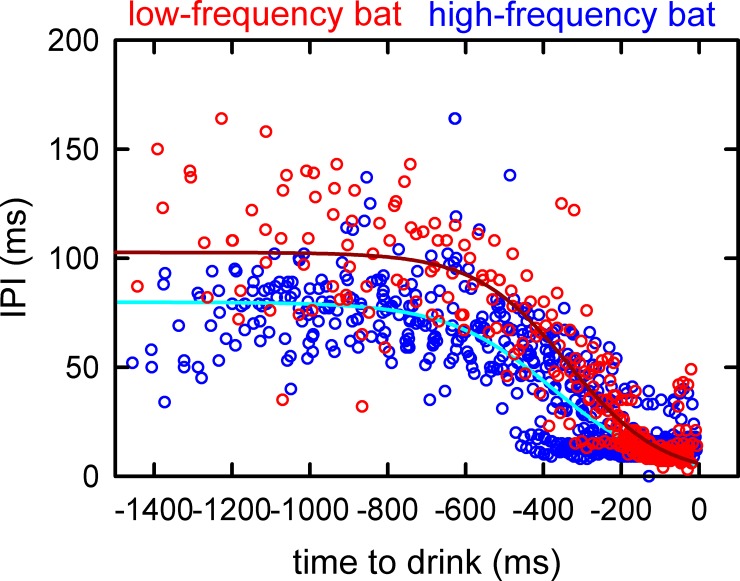
Plot showing stages of IPIs recorded from the completed drinking bouts by all bats.Time zero corresponds to the splash that signifies drinking. The sigmoid regression lines fit to the LF (low frequency, red) IPIs and HF (high frequency, blue) IPIs show a cruising flight with relatively stable IPIs (~100–105 ms for LF; ~75–80 ms for HF) until about 700 ms prior to drinking, followed by a progressive decline in IPIs until 300–400 ms before drinking, and finally a brief burst of rapidly-emitted pulses as a drinking buzz from 300–400 ms down to zero (end of bout). For pulses emitted in the approach stage (prior to -700 ms; see Fig 2), the mean IPIs are significantly different between LF bats (99 ms) and HF bats (77 ms).